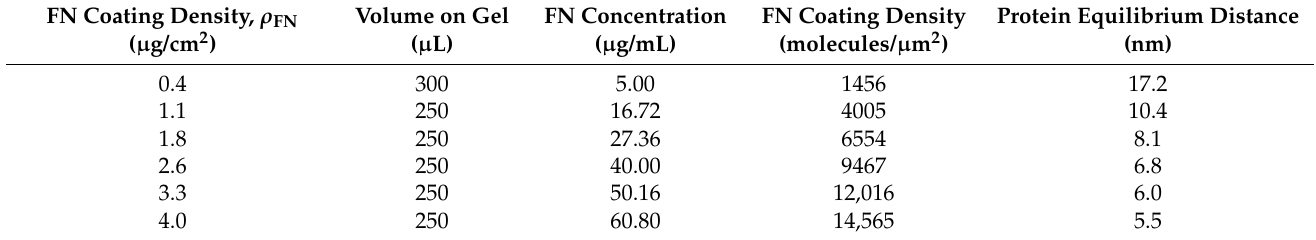
Table 2. Protocol for fibronectin coating